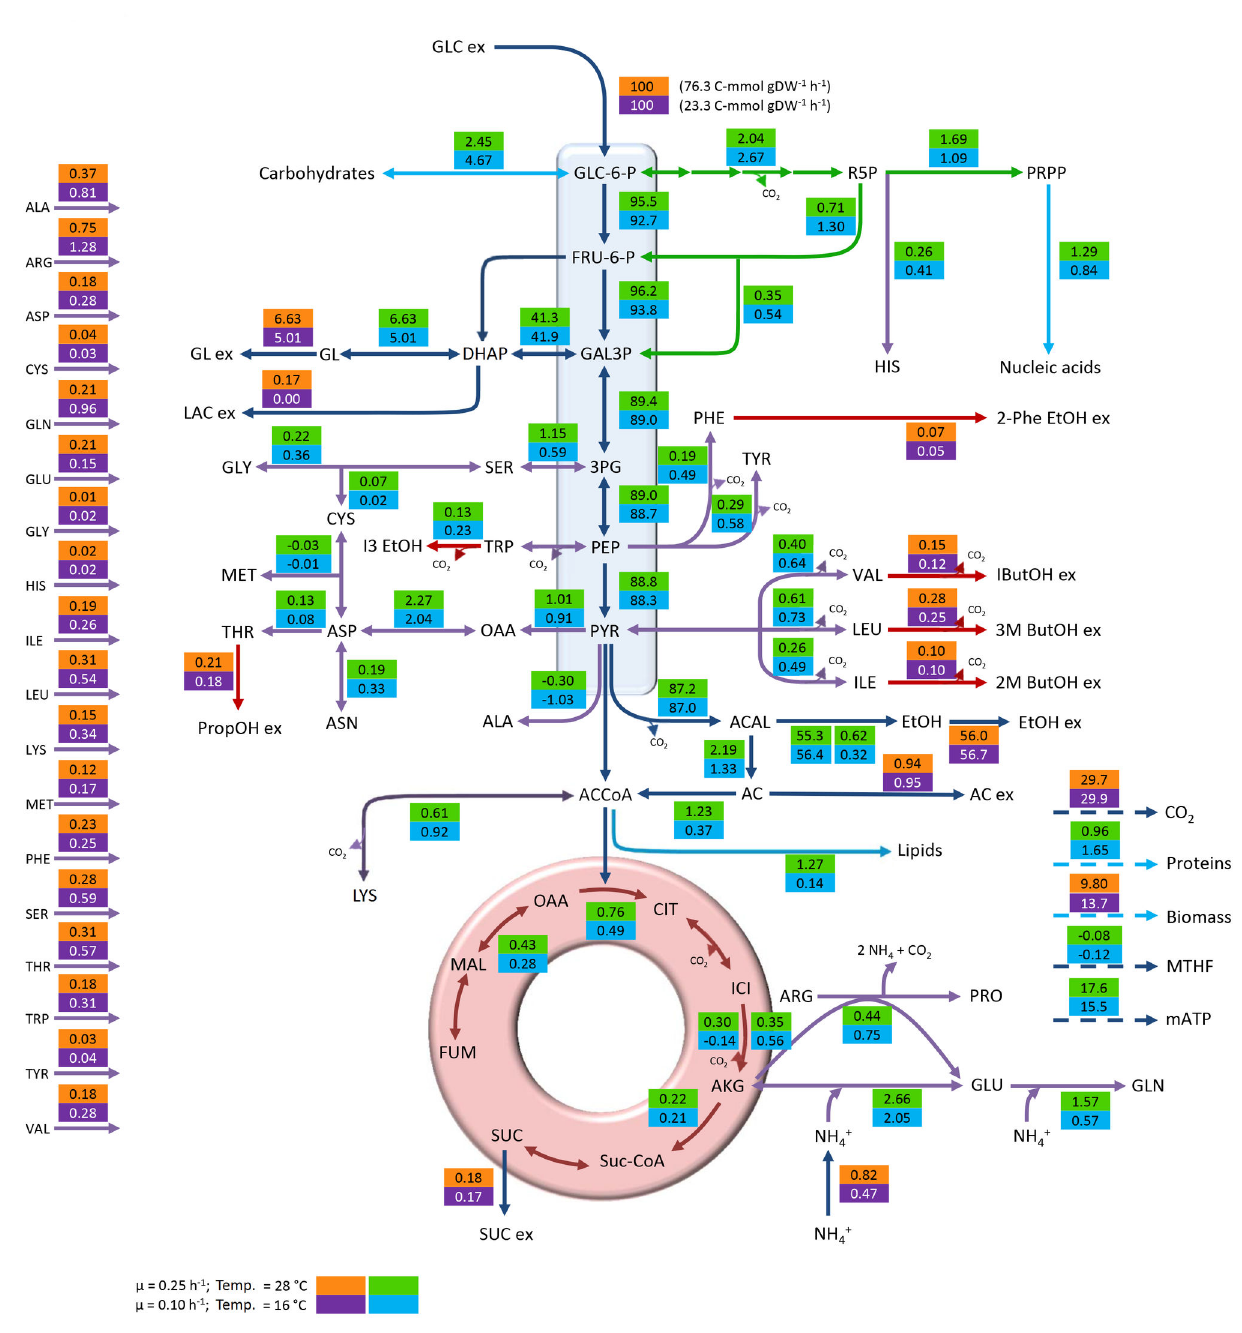
Figure 2. Distribution of metabolic fluxes at 280 g L -1 glucose expressed as C-mmol per 100 C-mmol glucose. The measured specific glucose uptake is shown next to the normalized value. Orange/purple boxes: measured and reconciled values; Green/blue boxes: calculated